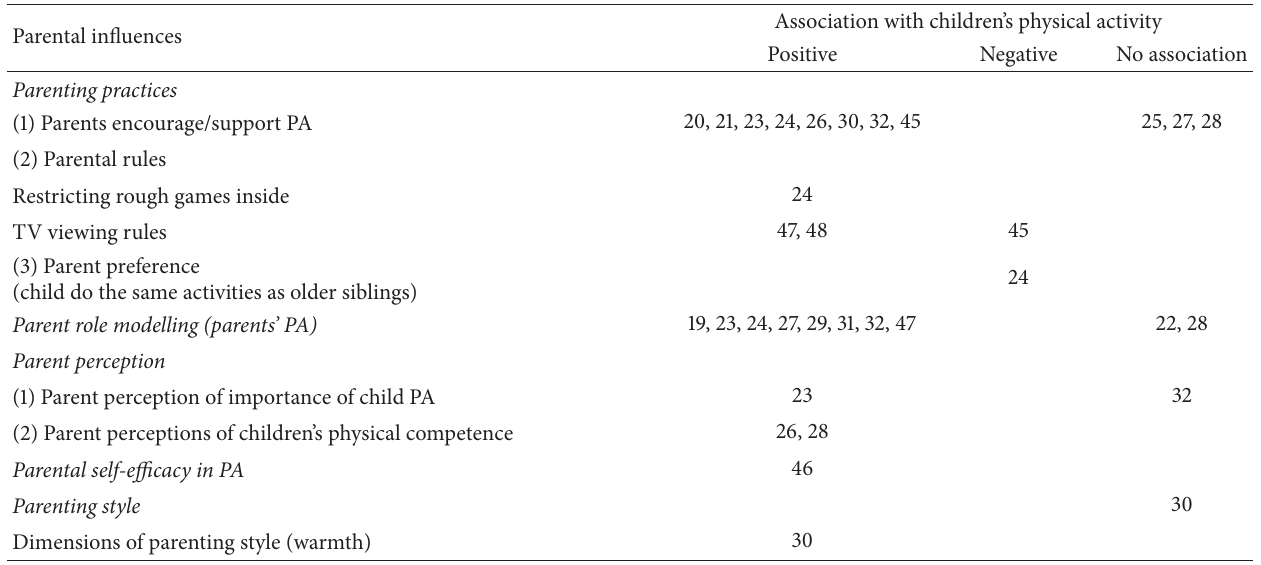
Table 5: Papers reporting an association between parental influences and children’s